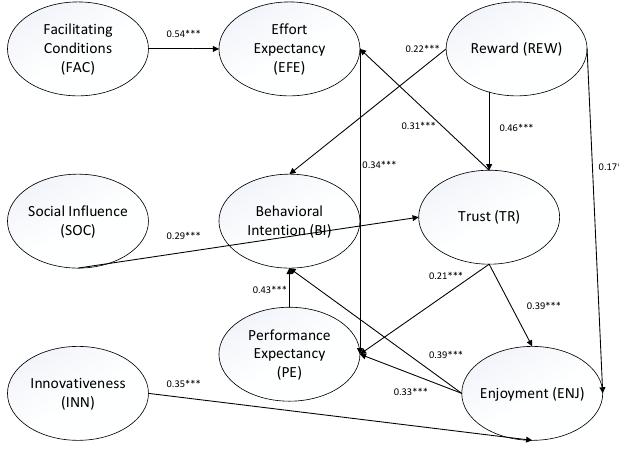
Figure 2. Results of the structural equation modelling. * p < 0.05. *** p < 0.001. Table 7. Path coefficients (standardized regression coefficients).